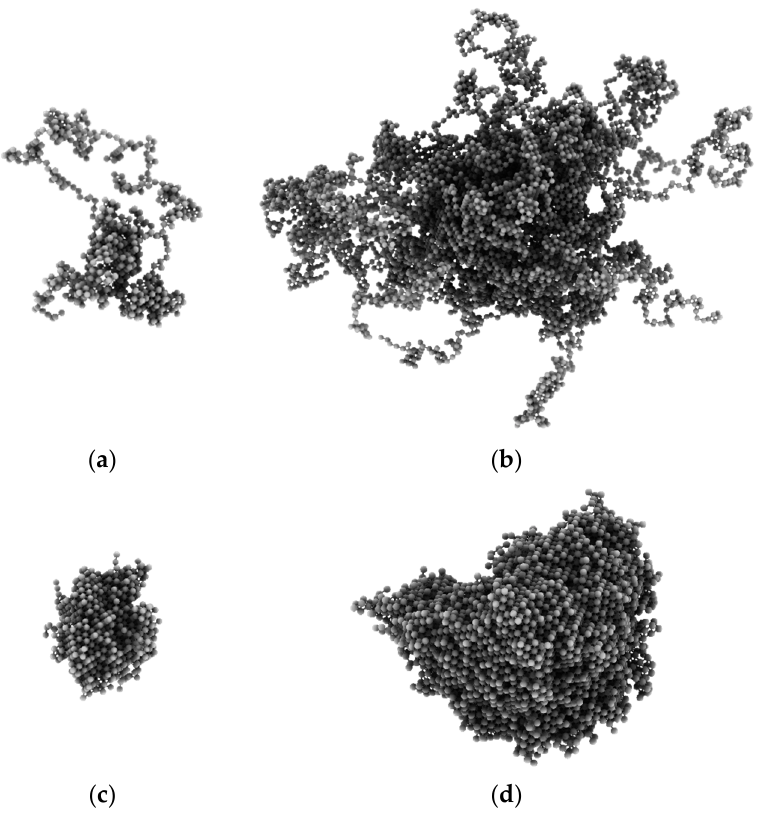
Figure 13. Snapshots of randomly selected star-branched polymers and dendrimers. The stars consisted of f = 4 ( a ) and f = 32 ( b ). The dendrimers ( c , d ) represent systems containing the same number of cores (macromolecules) as those with stars presented in the upper row.